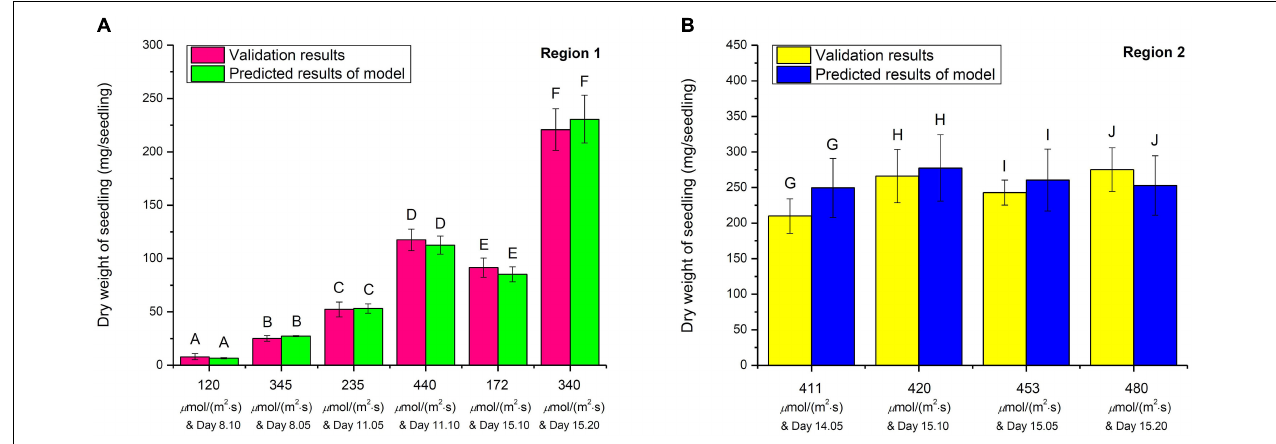
FIGURE 8 | The validation studies on 3D light-time-biomass response model in (A) Region 1 and (B) Region 2. The same upper cases (A, B, C, D, E, F, G, H, I, and J) between respective validation result and predicted result of model indicate that there were no significant differences of dry weights among all the selected combinations of light intensities and duration in Region 1 and Region 2, respectively ( n = 6, Student’s t test, p < 0.05). TABLE 6 | The robustness tests of 3D light-time-biomass response model of choy sum seedling. Model Region Variable Parameters ANOVA Statistics Coefficient t -value Prob > | t | F value Prob > F